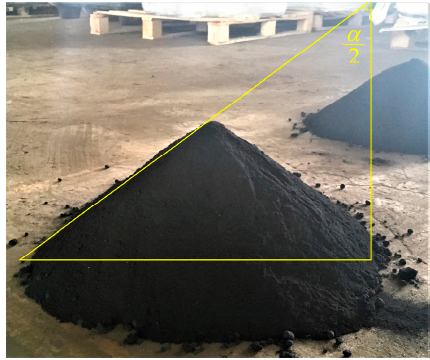
Figure 3. Measuring the vertex angle of piles of green cokes.